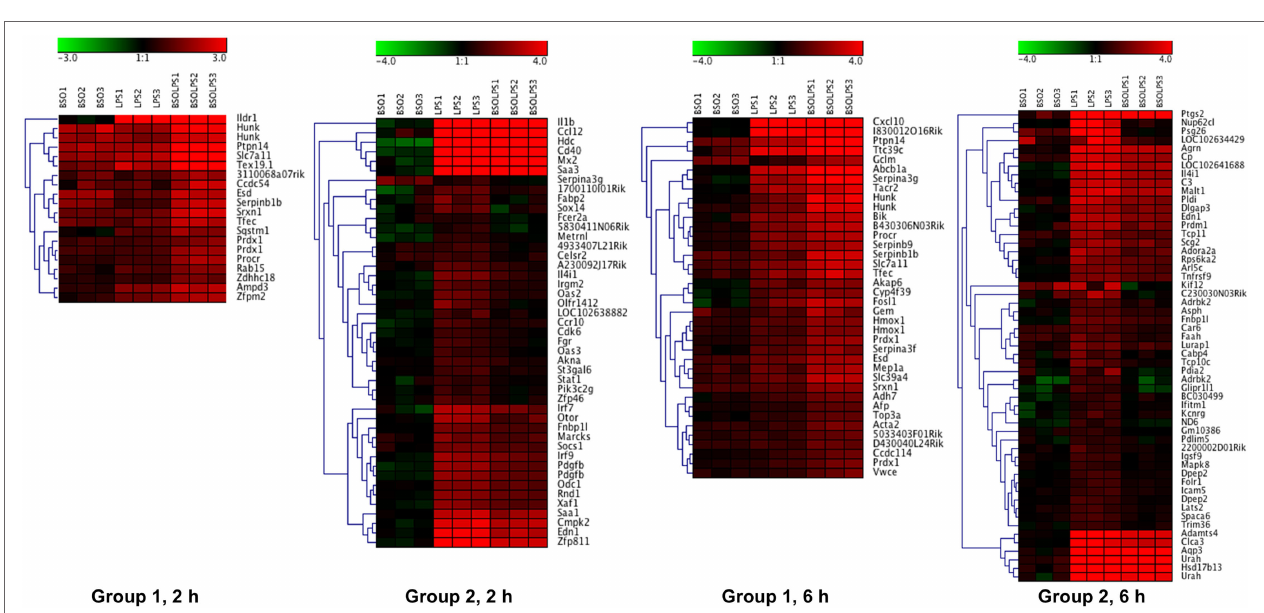
FigUre 3 | Patterns of gene expression. Cluster heat maps of transcripts in Groups 1 and 2. For each sample (3 BSO, 3 LPS, 3 BSO + LPS), the log 2 fold change in gene expression vs the mean of three controls is represented. LPS, lipopolysaccharide; BSO, buthionine sulfoximine.